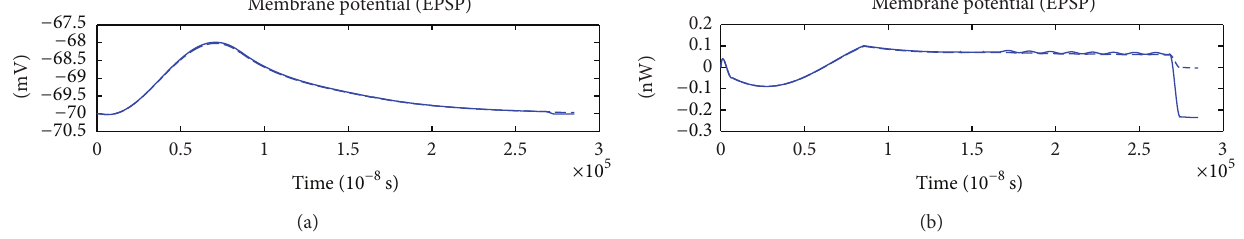
Figure 18: The EPSP and the corresponding energy function. 𝑟 0𝑚 = 0.0001 Ω , 𝑟 1𝑚 = 0.1 Ω , 𝑟 2𝑚 = 1000 Ω , 𝑟 3𝑚 = 0.1 Ω , 𝑟 𝑚 = 1000 Ω , = 1 𝜇 F, 𝐿 = 50 𝜇 H, 𝑖 = 7.155 𝜇 A, and 𝑄 = 1 × 10 −7 𝜇 A. 𝐶 𝑚 𝑚 0𝑚